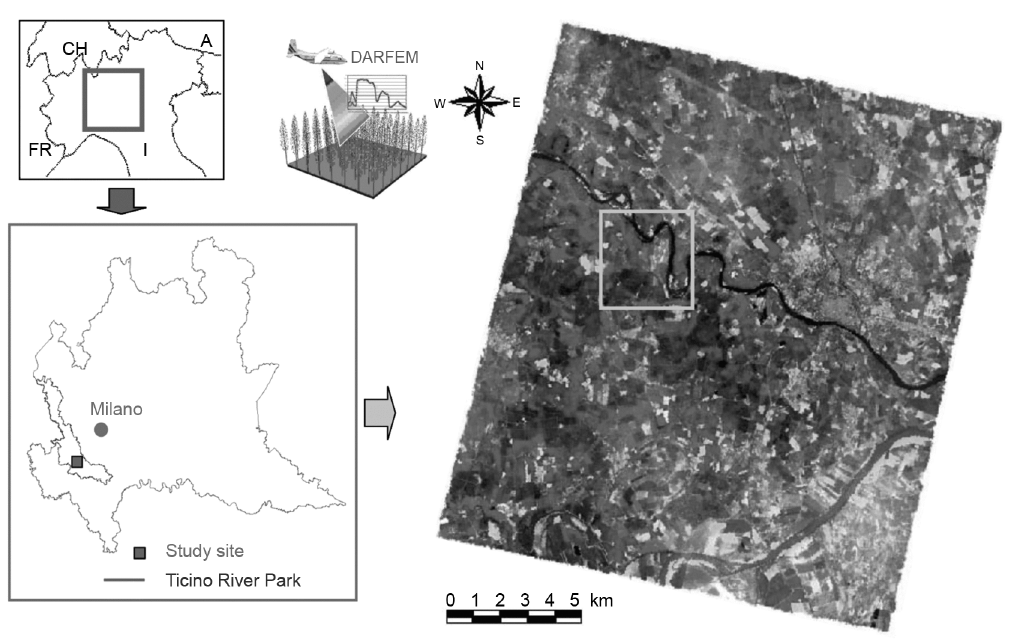
Fig. 1. Location of study site within the Ticino River regional park; Landsat-7 ETM+ image of the target area with the Ticino water course acquired